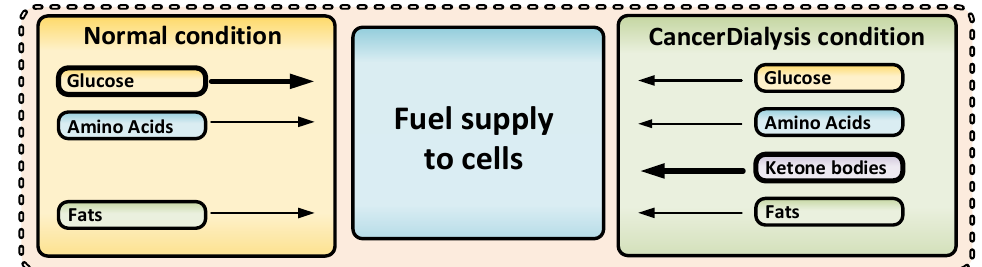
Figure 5. During CancerDialysis healthy cells as well as cancer cells (except hepatic and red blood cells) must shift from their dependency on glucose and amino acids towards ketones. This shift from a normal physiological state to a ketogenic condition, is a shift that healthy cells are programmed to do timely during food shortages, an ability that cancer cells, which are more addicted to fermentable fuels as glucose and glutamine, may be more vulnerable to. To induce KC and low glutamine levels with dialysis may therefore work as a multi-combinatorial treatment, potentially with few side effects when healthy cells timely can adapt to KC.